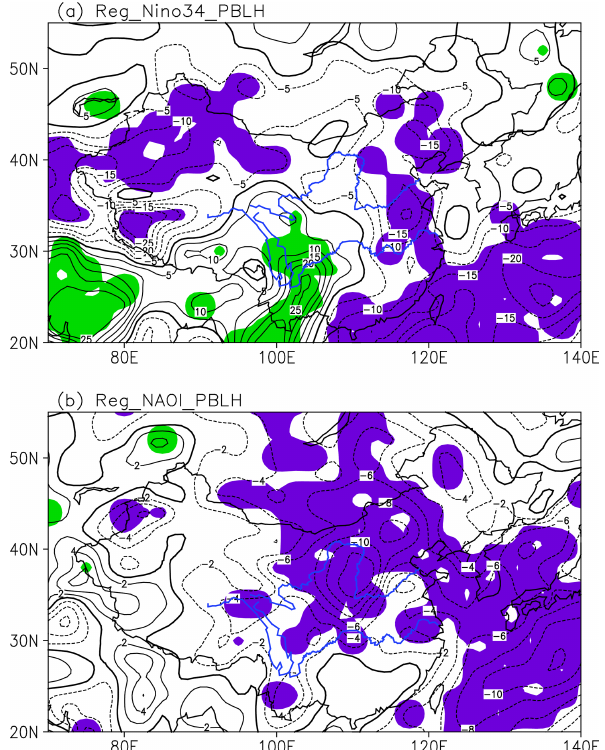
Figure 10. Regressions of the skin temperature onto the (a) 3 month leading Niño 3.4 index and (b) simultaneous NAOI. Color shading indicates significance at the 0.05